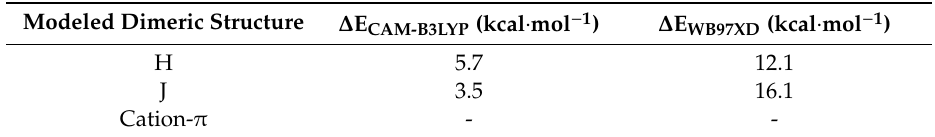
Table 1. Calculated energy di ff erences among the dimers in the vacuum with CAM-B3LYP and WB97XD functionals and 6-31G(d) basis set, considering the counterpoise correction.